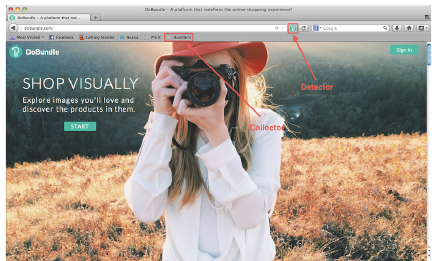
Figure 3: Product collector bookmarklet on a user’s